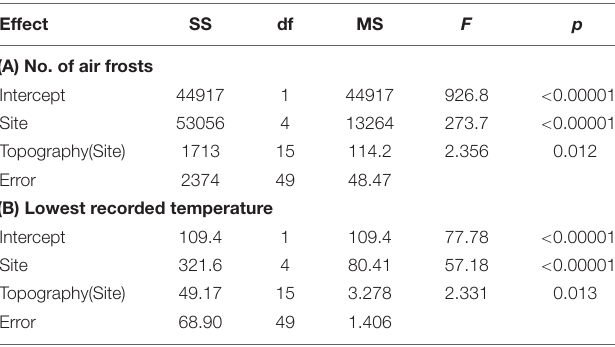
TABLE 1 | Summary of nested ANOVA testing effects of locality and topographic position on frost regimes, across five localities differing widely in macroclimate. Effect SS df